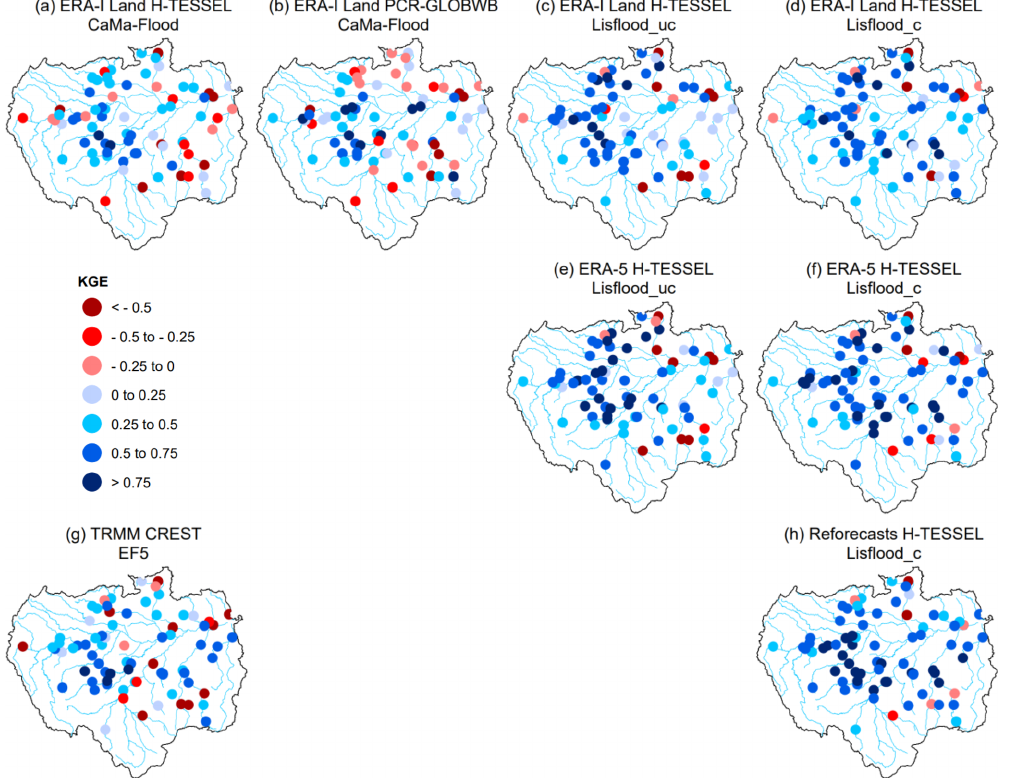
Figure 2. Full Kling–Gupta efficiency (KGE) scores at the 75 hydrological gauging stations for all simulations. For the periods 1997–2015 and 2004–2015 for the Coupled Routing and Excess Storage, Ensemble Framework for Flash Flood Forecasting (CREST EF5) run (g). Values greater than 0.75 are considered to indicate good performance (i.e. dark blue circles). To allow for easier model comparisons, plots are arranged by the different precipitation datasets (rows) and routing models (columns), with the exception of CREST EF5 (g). For example, the final column consists of model runs using the calibrated Lisflood routing